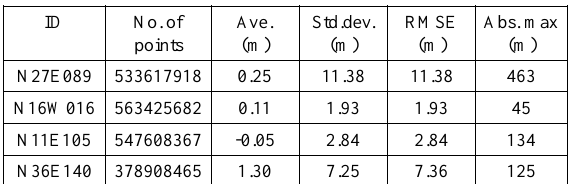
Table 4. Stats of height difference between the DSM tiles and the SRTM-3 (DSM minus SRTM-3)